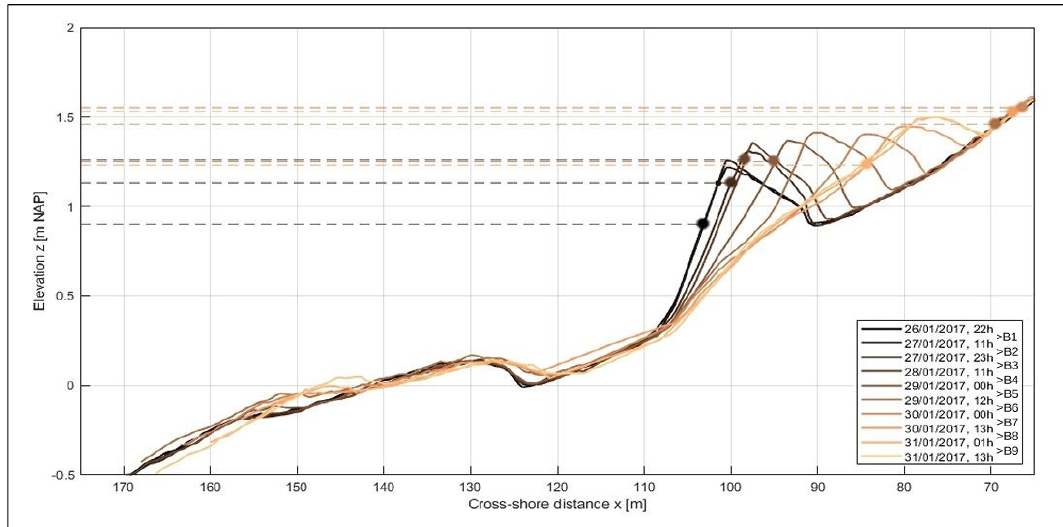
Figure 11 . Low waterbed levels for period B (M2 in Figure 7) from 26 to 31 January 2017. The dashed lines indicate the total high water level after each subsequent low water period. B1–B9 indicates time periods shown in Figure 12.